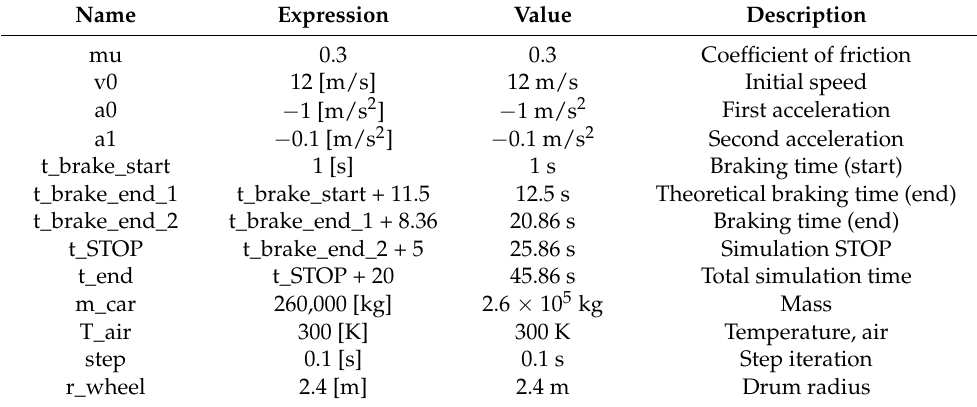
Table 4. Simulation parameters definition in COMSOL